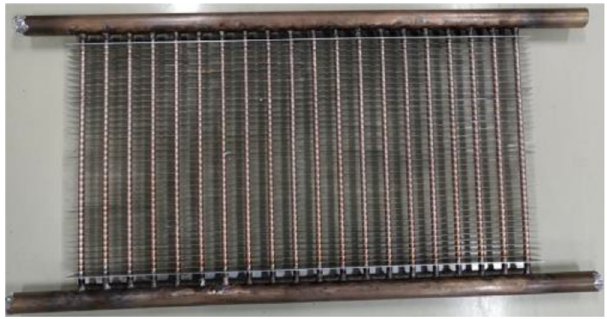
Fig. 7. Compact heat